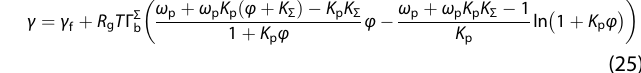
equilibrium constant is a kinetic parameter obtained by models from the literature, summarised in ‘ Surface kinetics ’ . The other parameters are developed in this work using geometric principles and characteristic length scales, which would, for clarity, bene fi t from a summary in Table 4.